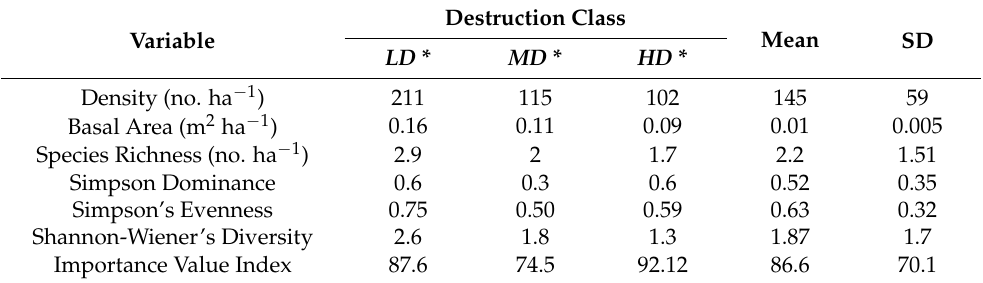
Table 3. Stand structure and composition by a destruction class of trees DBH ≥ 5 cm and height ≥ 1.5 m in a naturally-regenerated broadleaf forest in the Arasbaran biosphere reserve in Iran ( n = 30). Equations for variables are listed in Table 1. See Table 2 for a description of the destruction class.